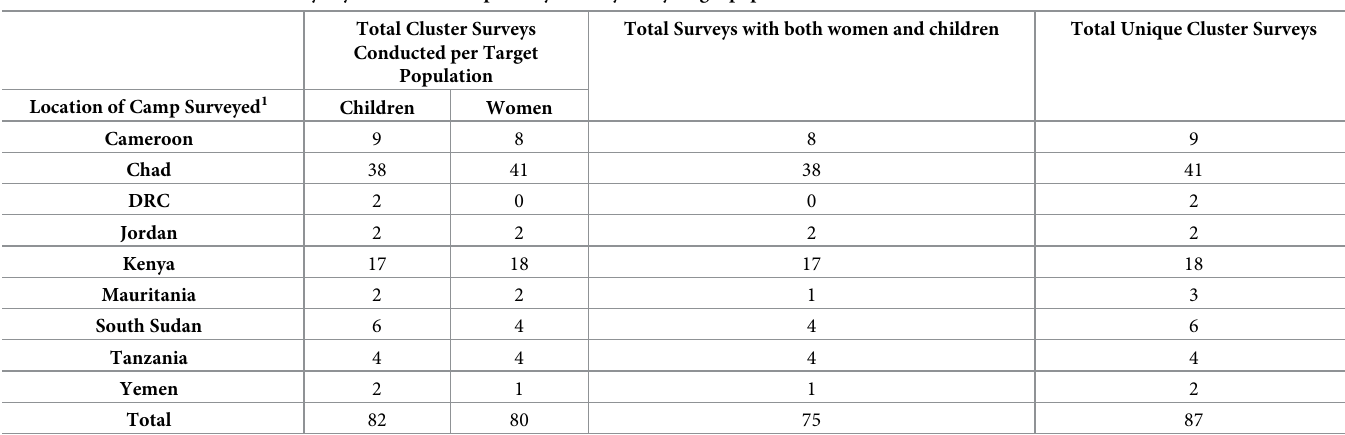
Table 1. Distribution of cluster surveys by location of camp surveyed and year by target population.